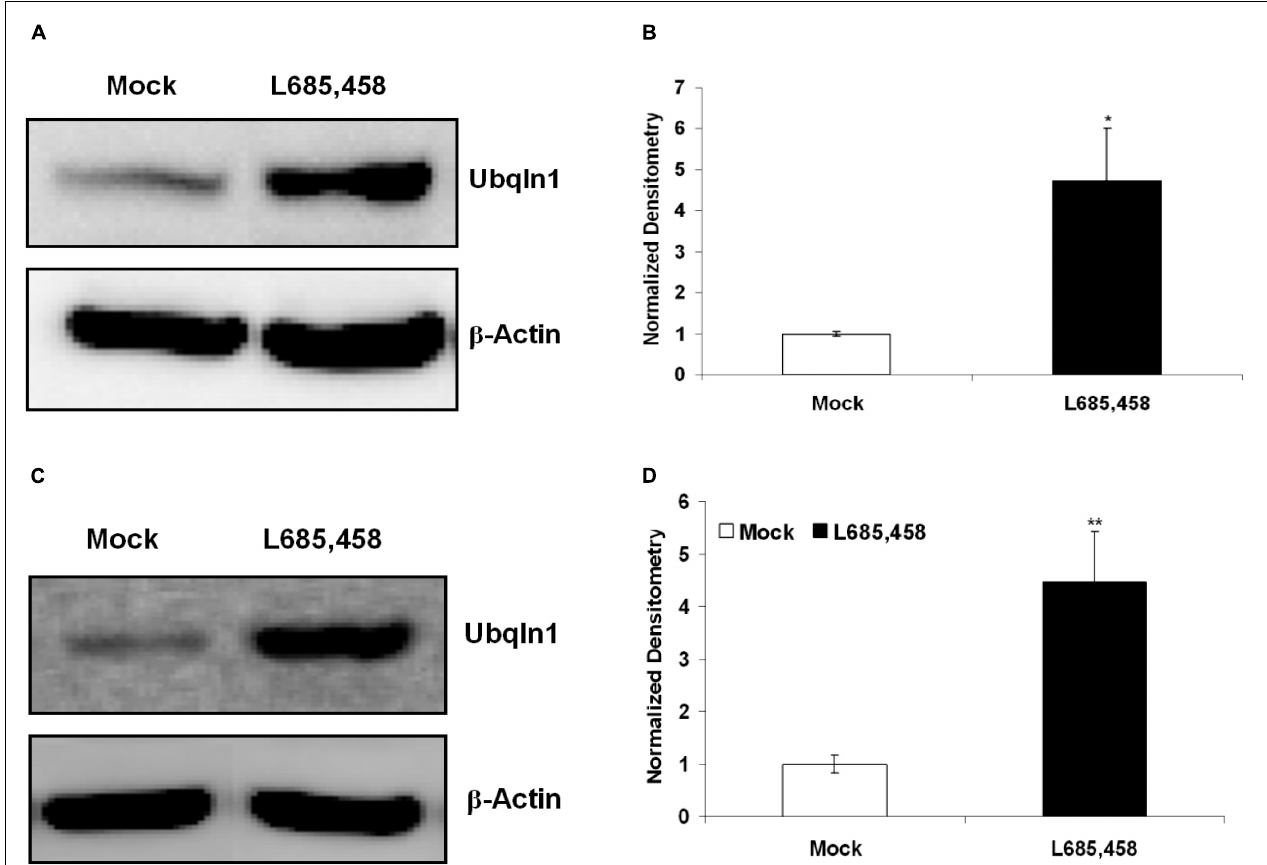
FIGURE 5 | Inhibition of γ -secretase increases ubiquilin-1 protein levels. (A) L685,458 increased ubiquilin-1 protein levels in SH-SY5Y cells. Naïve SH-SY5Y cells were treated with the mock solution (DMSO) or 5 µ M L685,458 (in DMSO) for 1 h. Cell lysates were prepared and applied to WB analysis. β -Actin served as the loading control. (B) Normalized densitometry for (A) . * p < 0.05. (C) L685,458 increases ubiquilin-1 protein levels in HEK-293 cells. Similar to (A) , naïve HEK293 cells were treated with the mock solution or 5 µ M L685,458 for 1 h. Cell lysates were prepared and applied to WB analysis. β -Actin served as the loading control. (D) Normalized densitometry for (C) . ** p <